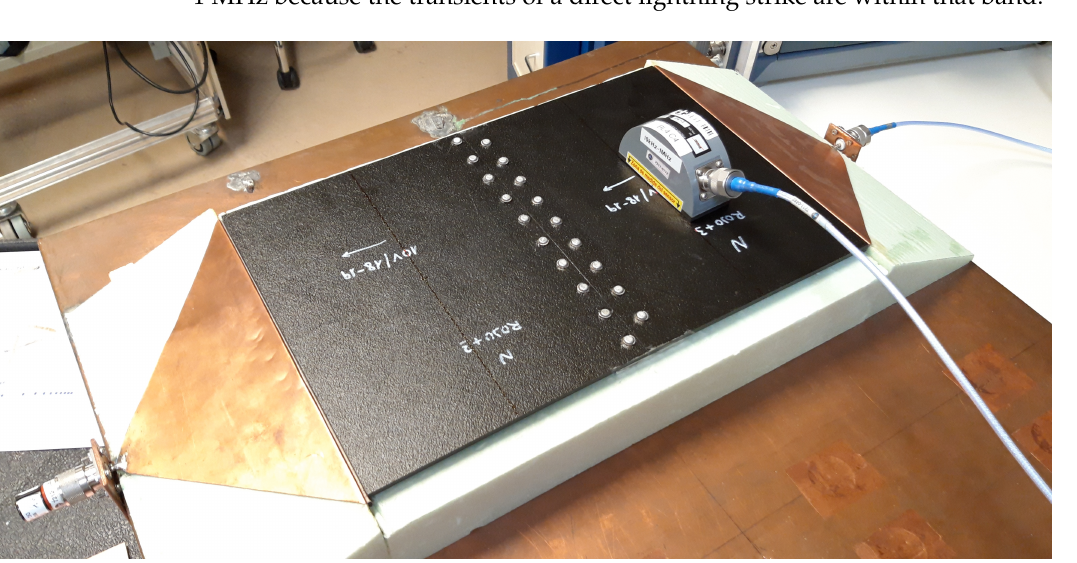
Figure 5. Surface current measurement with a multi-gap loop B-dot ground plane